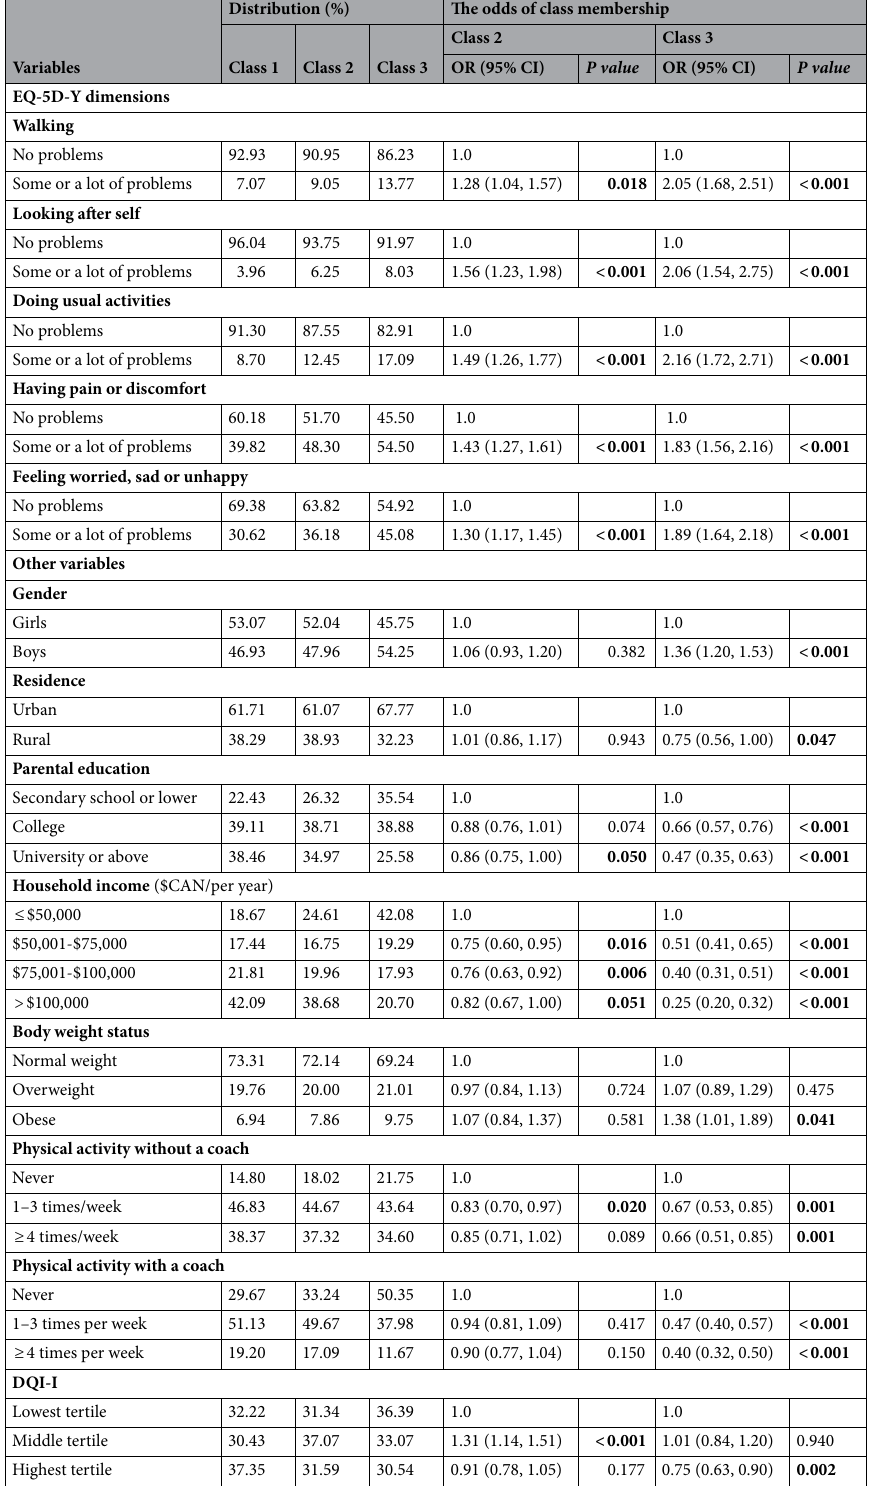
Table 3. Frequency distributions of the EQ-5D-Y dimensions, the socio-demographic characteristics, body weight, physical activity and diet quality by the class, and the odds of their class membership, grade five students participating in the 2008, 2010 and 2012 Real Kids Alberta surveys in Canada. Class 1: Healthy, Class 2: Less healthy, Class 3: Unhealthy. Class 1 was the reference group in the multinomial logistic regression. Bold P values indicate a statistically significance (p < 0.05). OR odds ratio, CI confidence interval, P p